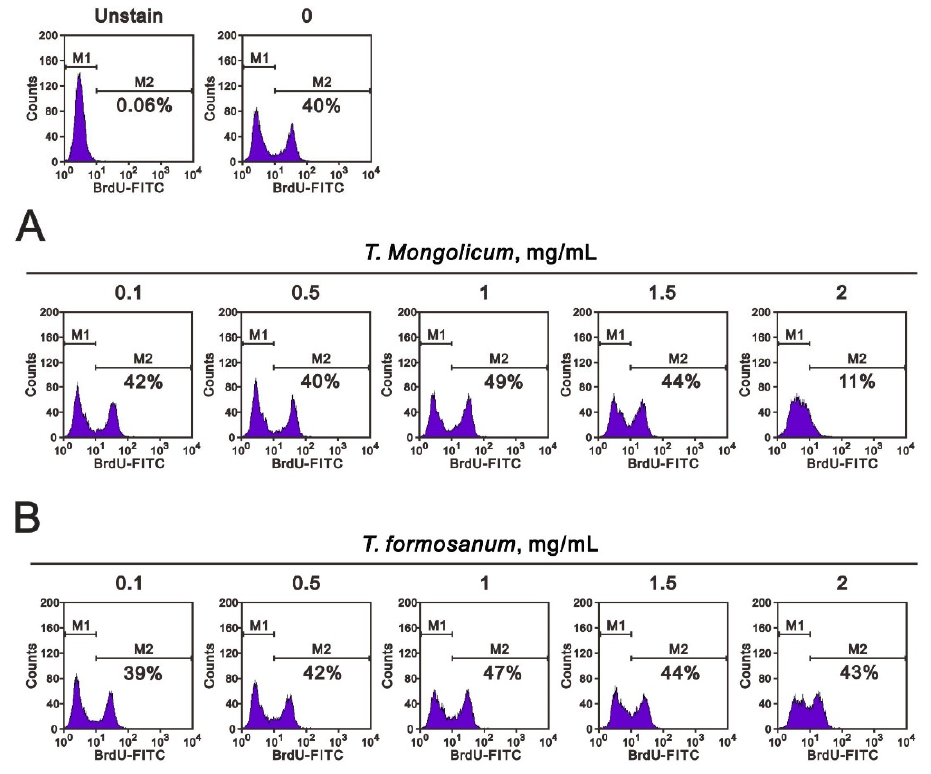
Figure 3. Effects of T. mongolicum and T. formosanum on MDA-MB-231 cell proliferation. MDA-MB-231 cells were treated for 48 h with the indicated concentrations of ( A ) T. mongolicum or ( B ) T. formosanum . They were then subjected to BrdU proliferation analysis.